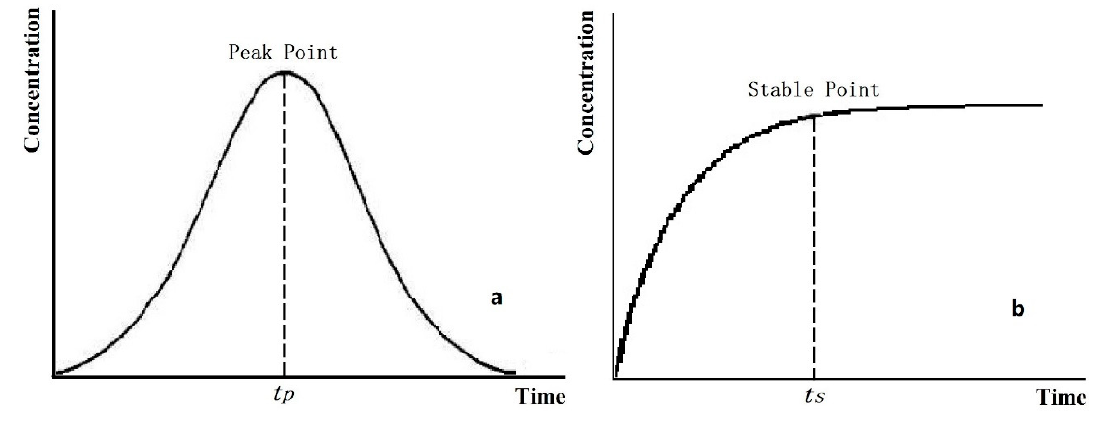
Figure 18. Schematic of the typical curves corresponding to di ff erent dispersion mechanisms.